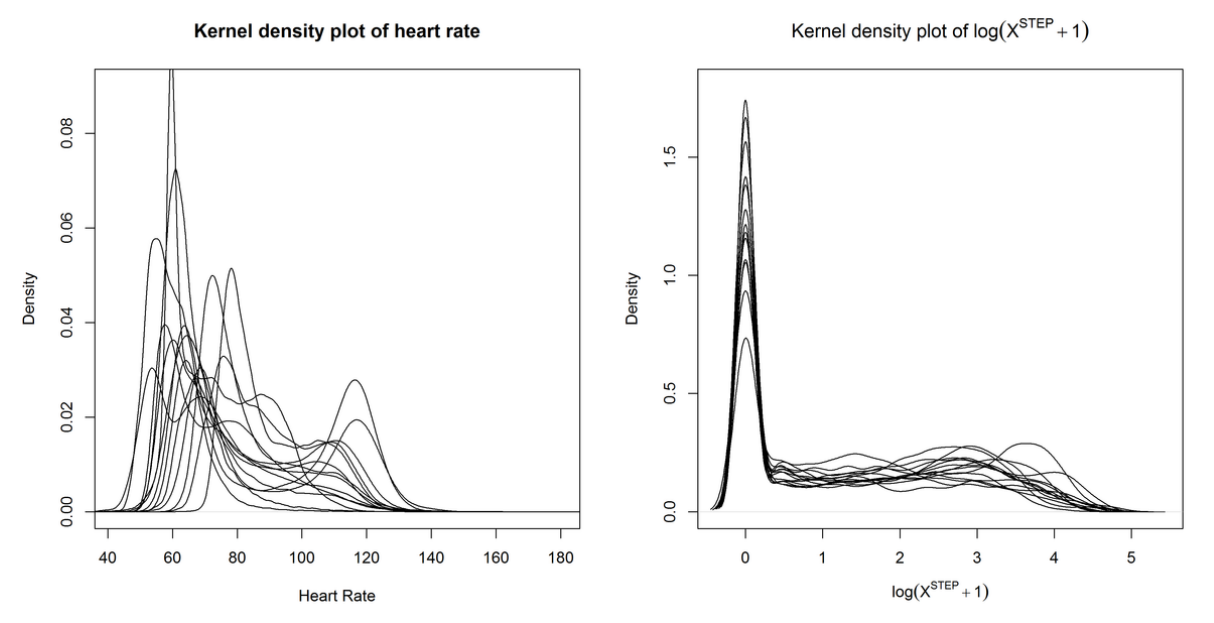
Figure 2. Kernel density plots for heart rate and log(X_STEP+1) for all participants.